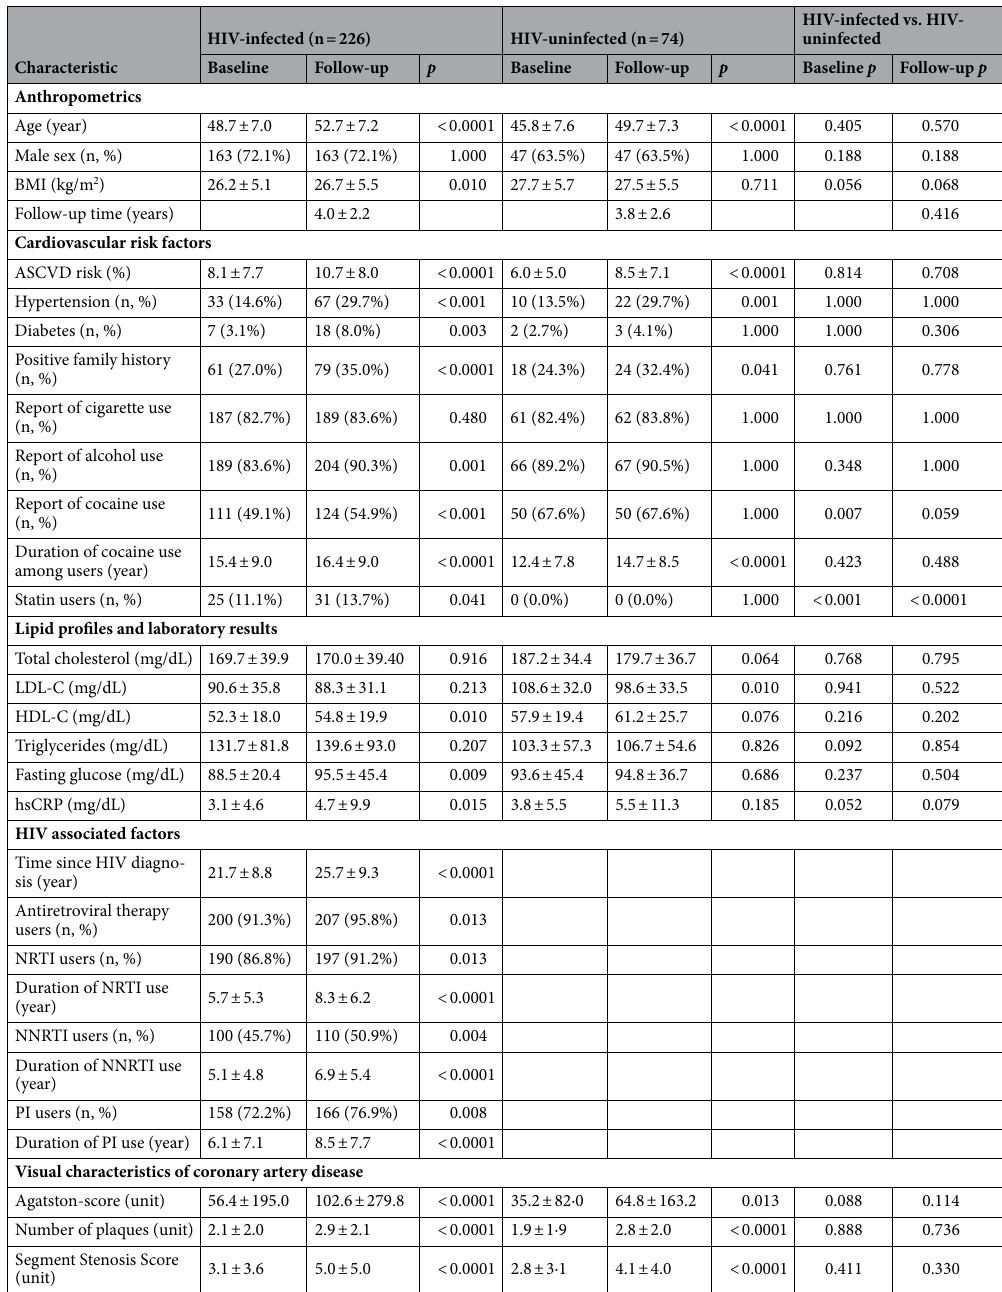
Table 1. Demographic, behavioral, clinical and laboratory characteristics at baseline and follow-up stratified by HIV-serostatus. Average and standard deviation for continuous variables, frequencies and proportion (%) for categorical variables are reported. p values are based on t-test or paired t-test as appropriate or chi-square test or McNemar-test as appropriate. Abbreviations: ASCVD risk cardiovascular risk defined by the ACC/ AHA Guideline on the Assessment of Cardiovascular Risk; BMI body mass index (kg/m 2 ); LDL-C low density lipoprotein cholesterol; HDL-C high density lipoprotein cholesterol; HIV human immunodeficiency virus; hsCRP high ‐ sensitivity C ‐ reactive protein; NRTI nucleoside reverse-transcriptase inhibitors; NNRTI non- nucleoside reverse-transcriptase inhibitors; PI protease inhibitors. Reused from: Kolossváry et al. Eur Radiol . 2021 Mar 3. https:// doi. org/ 10. 1007/ s00330- 021- 07755-7. Online ahead of